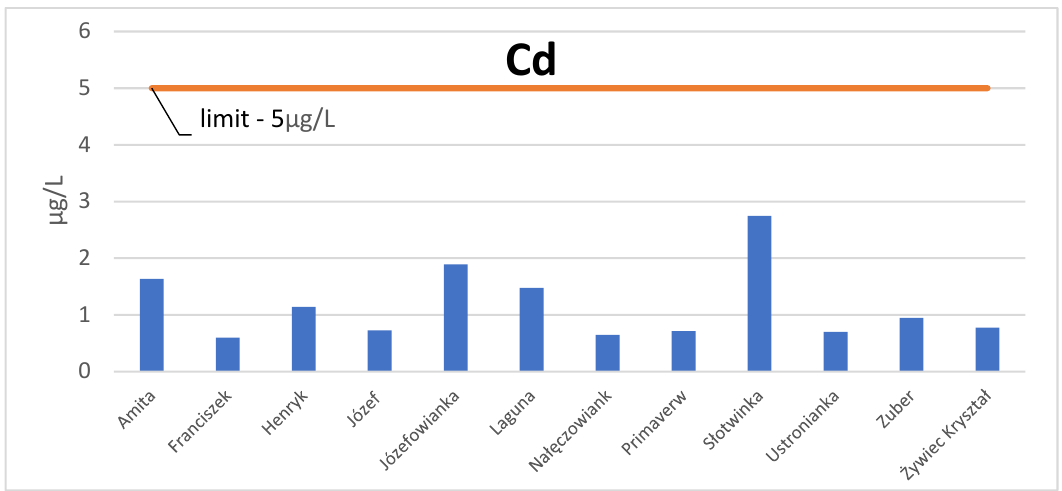
Figure 7. The concentration of lead in mineral waters ( μg/L ).